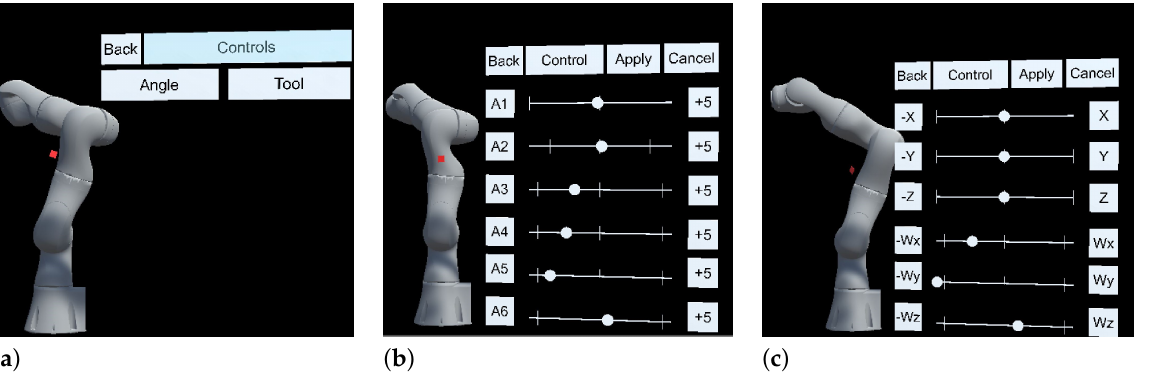
Figure 8. The manual manipulation interaction interfaces: ( a ) main menu panel; ( b ) joint positions jogging type; ( c ) Cartesian coordinate system jogging